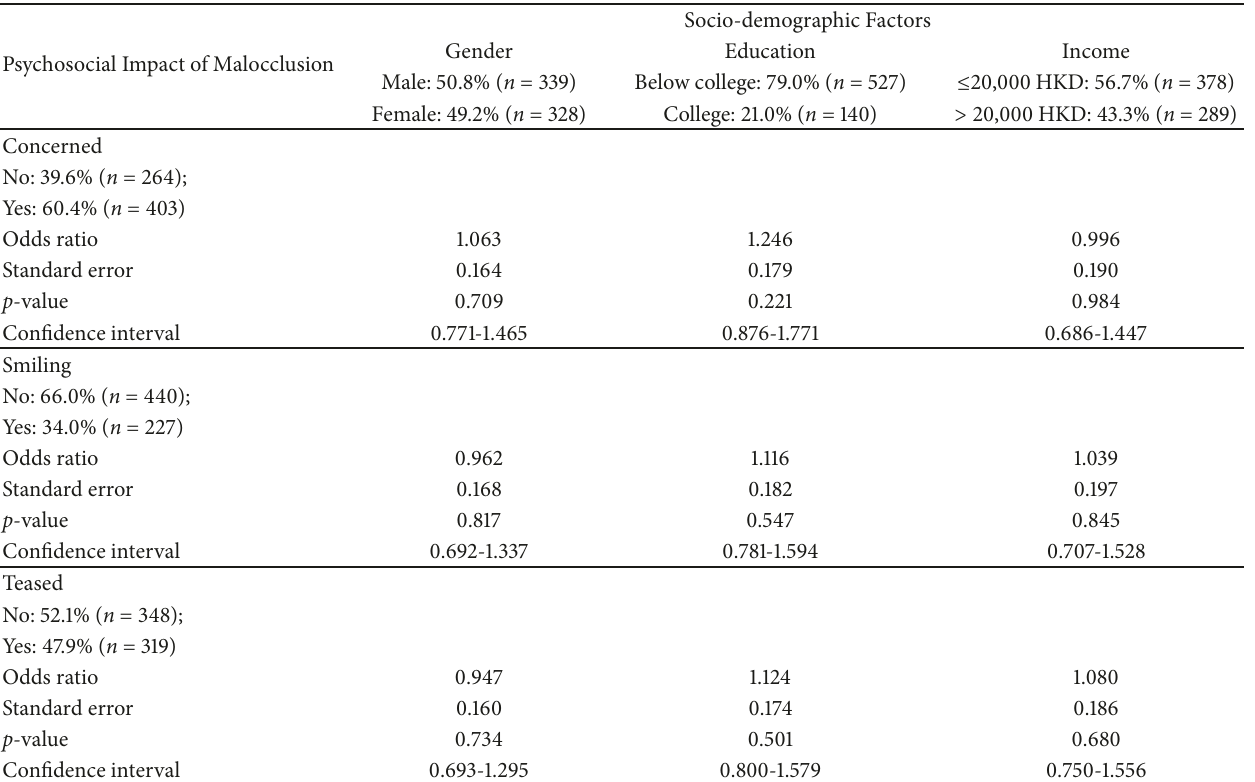
Table 5: Associations between the psychosocial impact of malocclusion and sociodemographic factors.